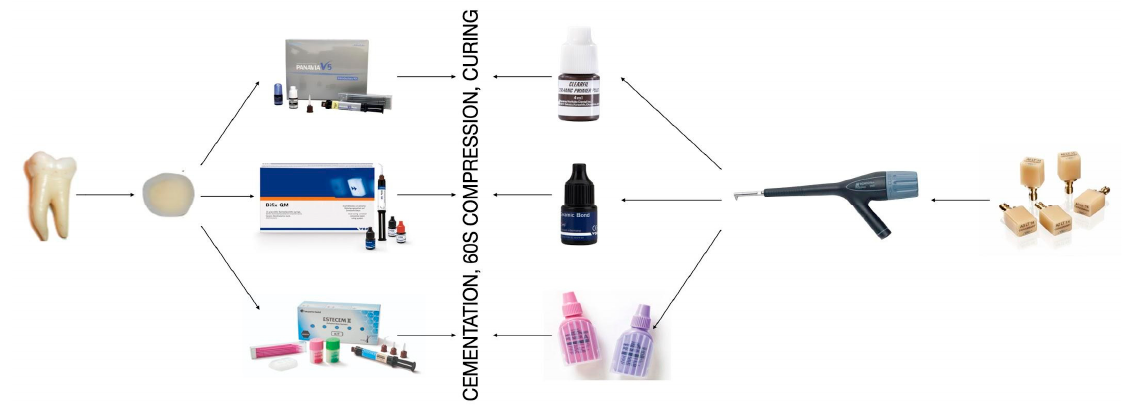
Figure 1. Schematic representation of the sample preparation protocol.